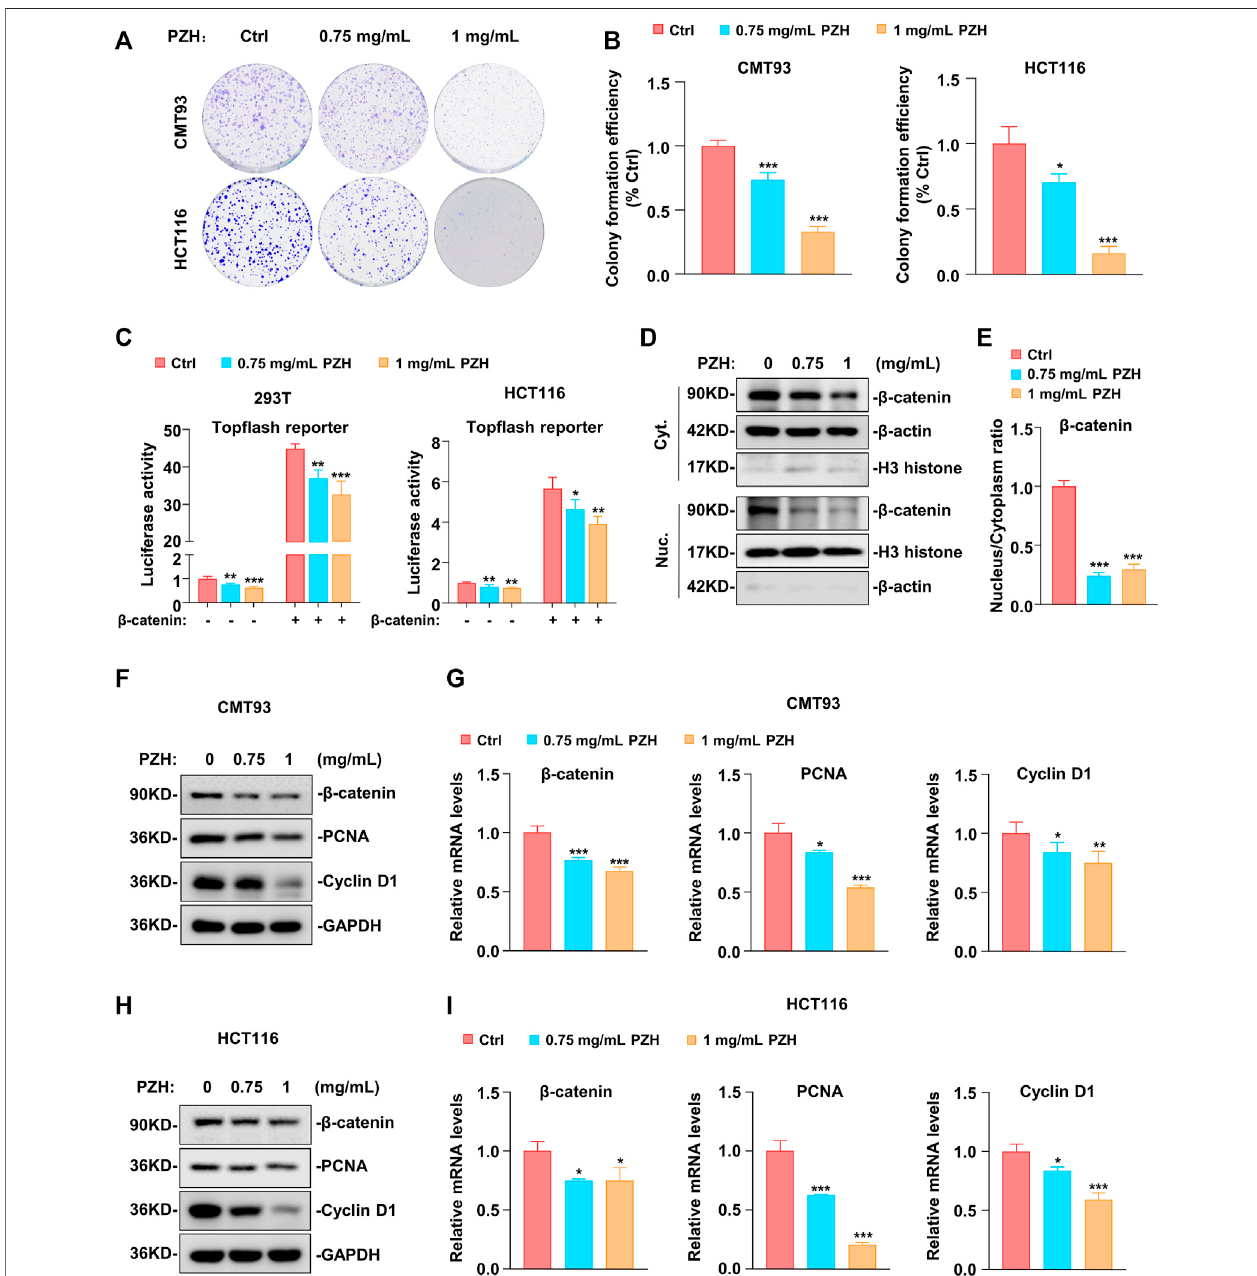
FIGURE 1 | PZH suppressed the proliferation of CRC in vitro by inhibiting the expression of β -catenin, Cyclin D1 and PCNA. (A – B) Representative clonogenic analysis (A) and quanti fi cation of monoclonal number ( B , n = 3 per group) of CMT93 and HCT116 cells. Tumor cells were treated with the indicated dose of PZH for 7 days, followed by methanol fi xation and crystal violet staining, imaging, and the number of monoclonal cells was analyzed by Image Pro Plus 6.0 software. (C) PZH suppressed the Top fl ash reporter activity which was induced by β -catenin in 293T and HCT116 cells ( n = 4 per group). (D) The cytoplasmic and nuclear protein levels of β -catenin were attenuated in PZH treated HCT116 cells. (E) PZH dramatically reduced the nuclear-cytoplasmic ratio of β -catenin ( n = 3 per group). (F – I) The protein (F,H) and mRNA ( G,I , n = 3-4 per group) levels of β -catenin, Cyclin D1 and PCNA were attenuated in PZH treated CMT93 and HCT116 cells. Tumor cells were treatedwiththeindicateddoseofPZHfor24h,followedbyWesternblotorqPCRanalysis.Theresultsarerepresentativeofoneofthreeexperiments.Dataarepresented as means ± SD, * p < 0.05, ** p < 0.01, *** p < 0.001 based on one-way ANOVA or two-sided Student ’ s t